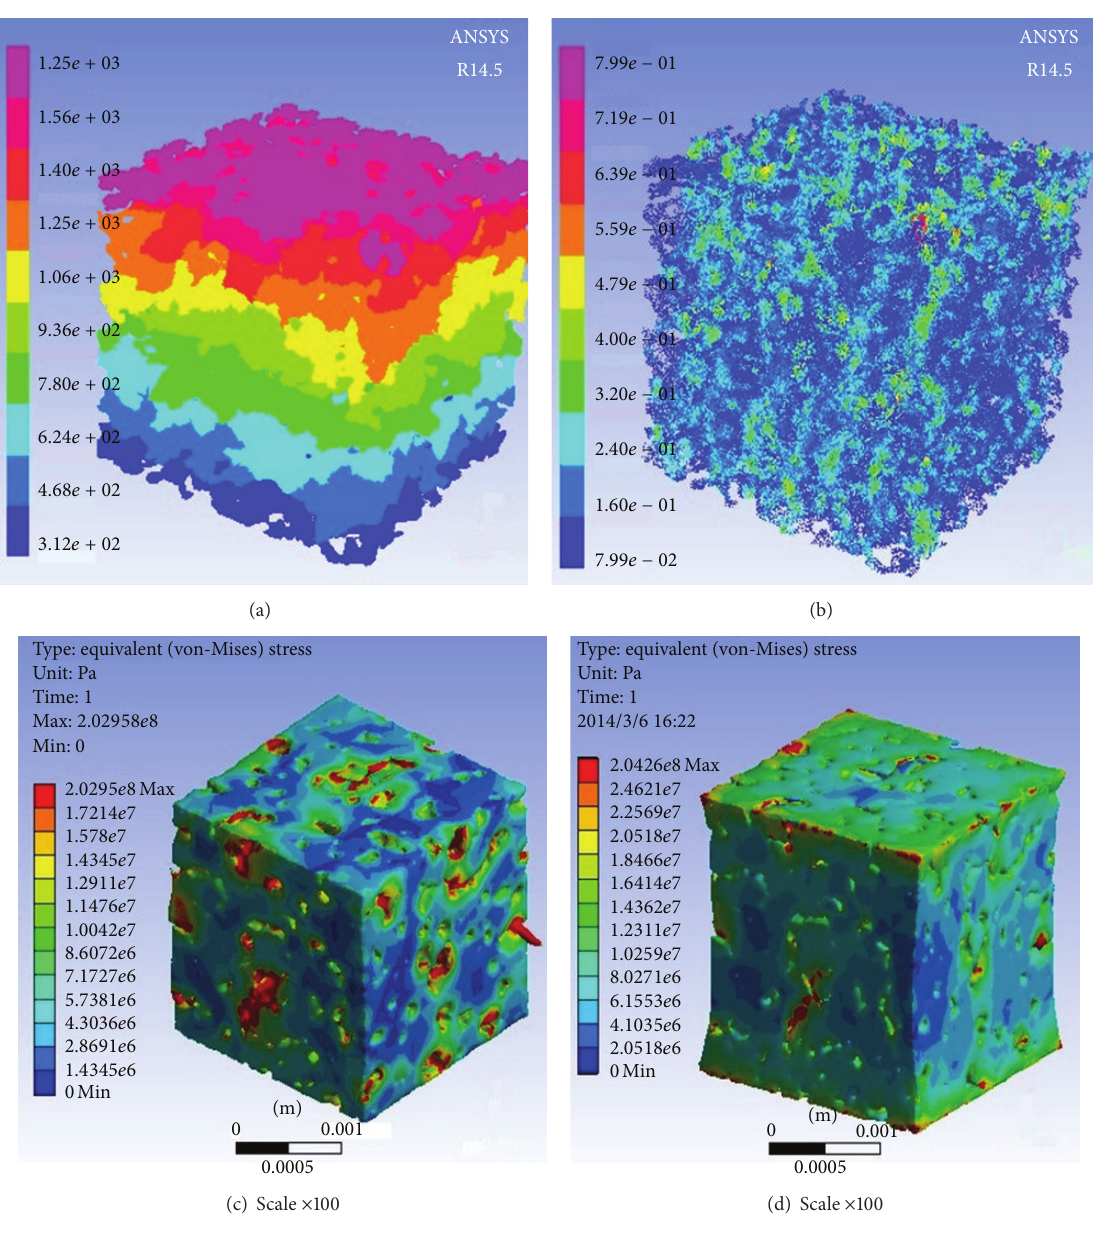
Figure 6: Simulation results images. (a) and (b) are the images of fluid pressure contours and velocity vectors at the pressure gradient 10MPa/m ( 𝑝 𝑖 = 1538 Pa, 𝑝 𝑜 = 0 Pa), (c) is the von-Mises stress field of S2 rock matrix at the pore pressure of 20 MPa ( 𝑝 𝑖 = 2𝑒7 + 1538 Pa, = 0 Pa), and (d) is the von-Mises stress field of S2 rock matrix at the condition of 𝑝 𝑝 𝑜